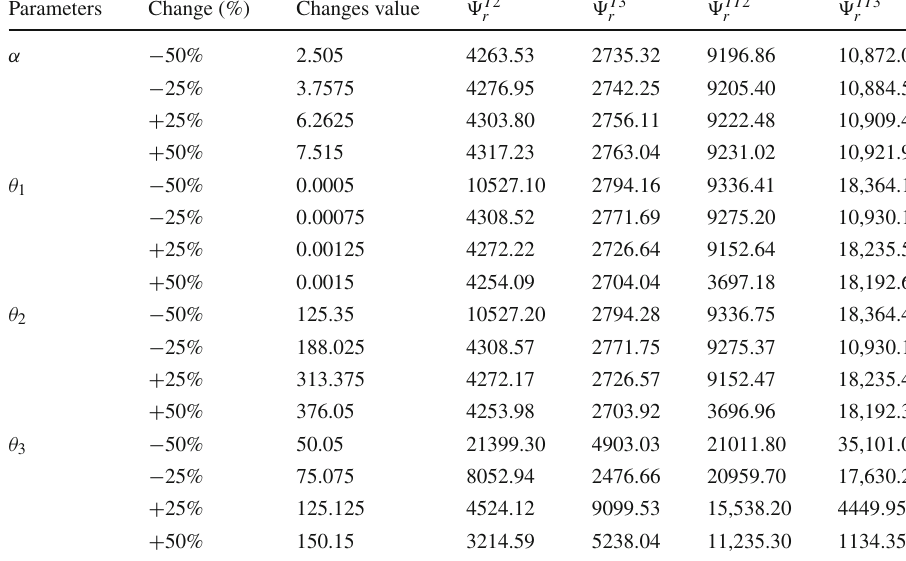
Table 9 Parameters changes value versus retailer’s profit in different